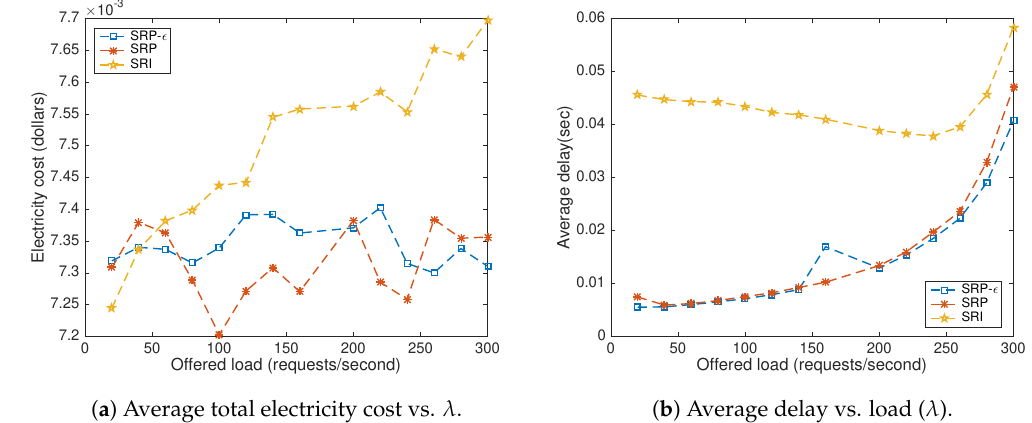
Figure 12. Influence of penalty parameter b